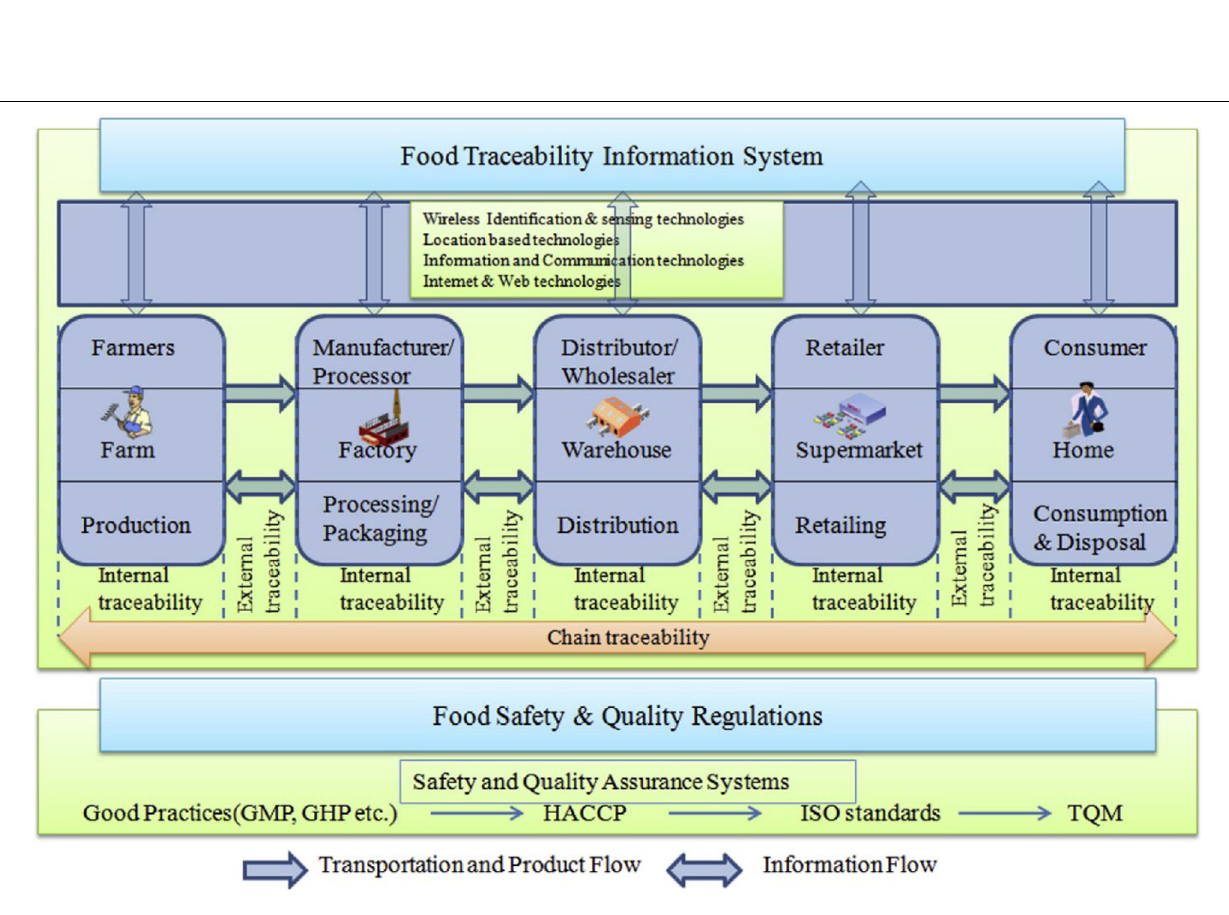
Frontiers in Blockchain |